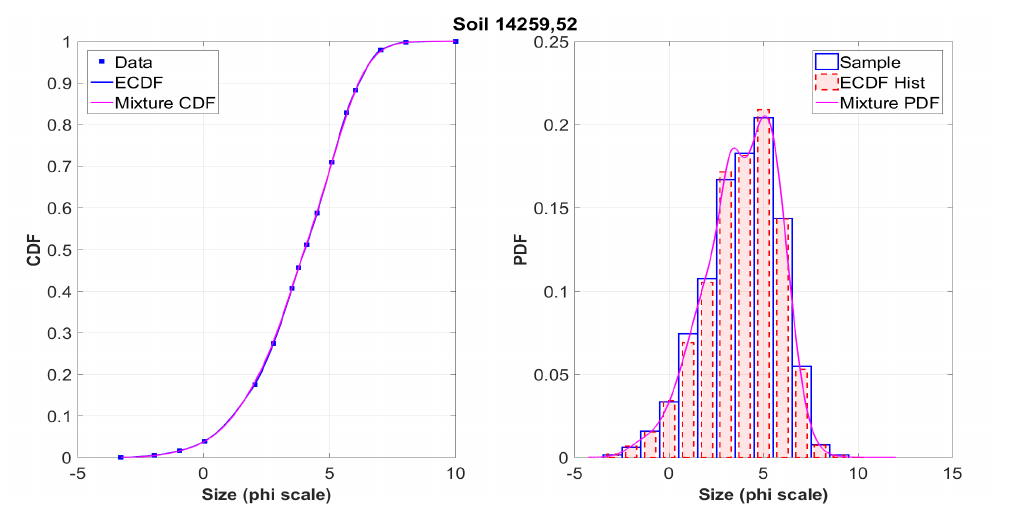
Figure A3. Soil 14259,52 (“Apollo